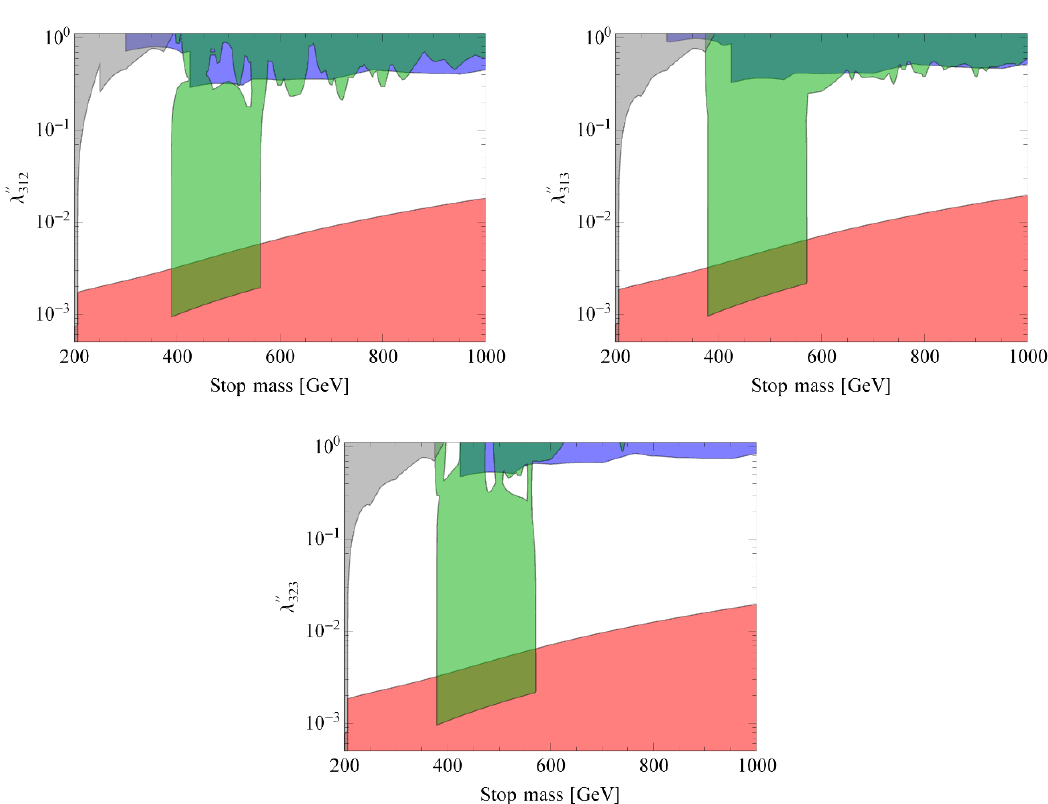
. 205 GeV) is excluded by paired t couplings and 3 ij